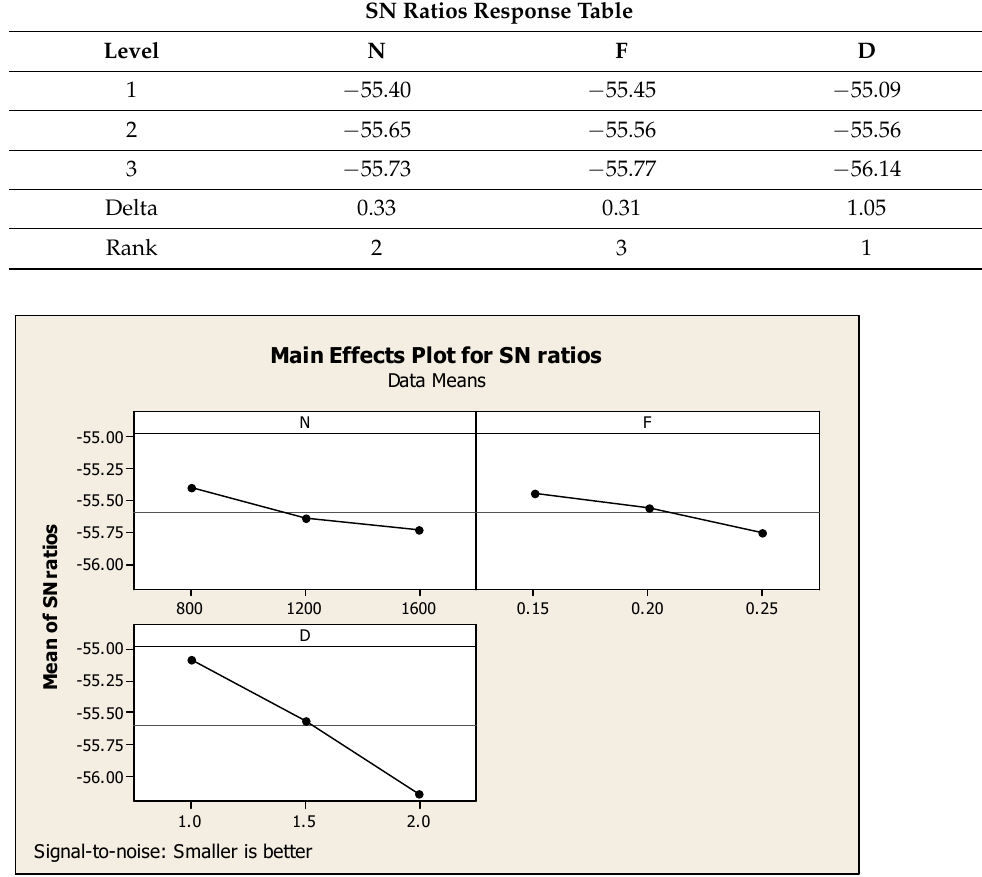
Figure 11. SR and CF-related major effects diagram with respect to signal-to-noise ratios.